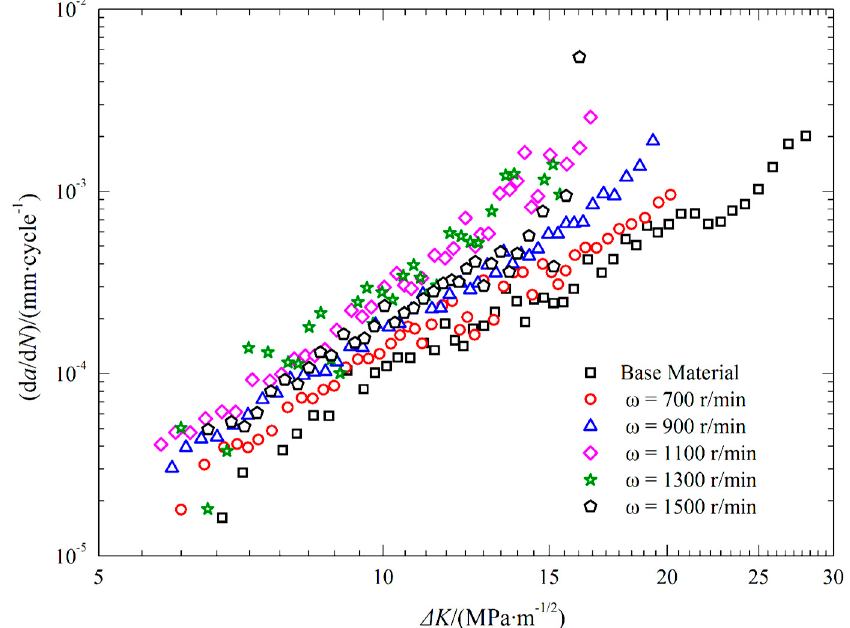
Figure 9. Fatigue crack growth rates at different rotating speeds when the advancing velocity was ν = 110 mm/min.